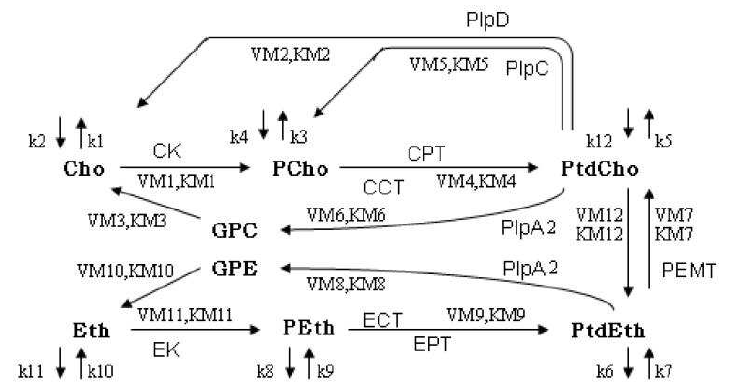
Figure 1: Schematic representation of the model. Arrows with V M i and KM i param- eters refer to enzymatic reactions while the rest represent simple reactions. Reactants: